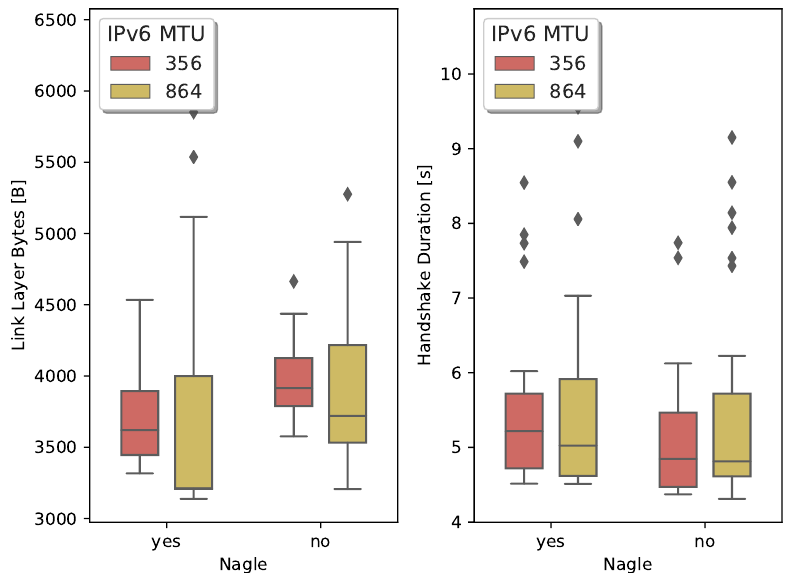
Figure 6. Limiting the MTU, by negotiating a small Maximum Segment Size (MSS) in the TCP handshake, reduces the number of bytes retransmitted and improves the handshake duration.